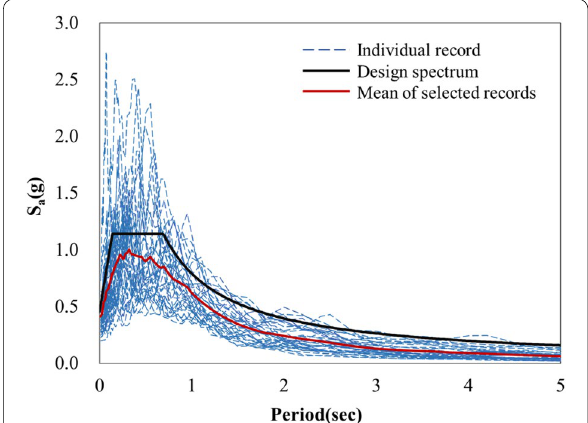
Fig. 8 Response spectrum of selected earthquake